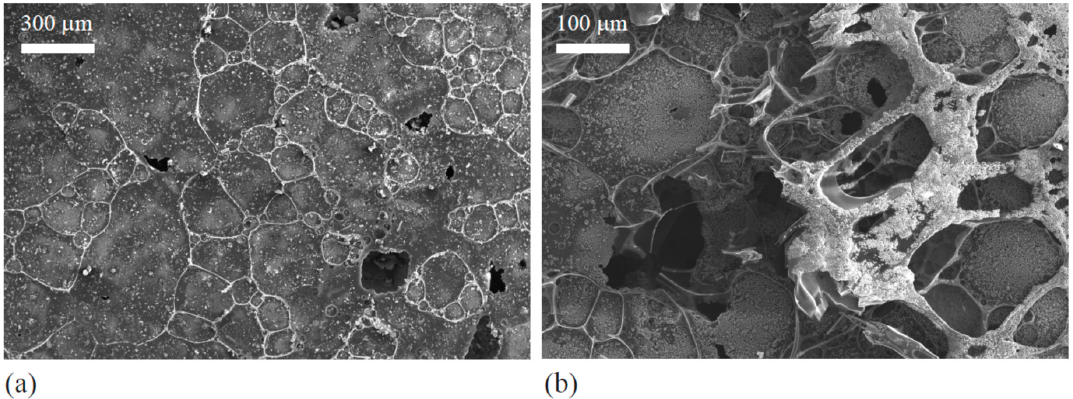
Figure 6. SEM images taken from the surface of the C/Al composite showing: ( a ) corrosion development inside the grain due to the active dissolution of aluminum in 0.1 N sulfuric acid, ( b ) corrosion product pile-up on the surface of the specimen due to seawater corrosion.